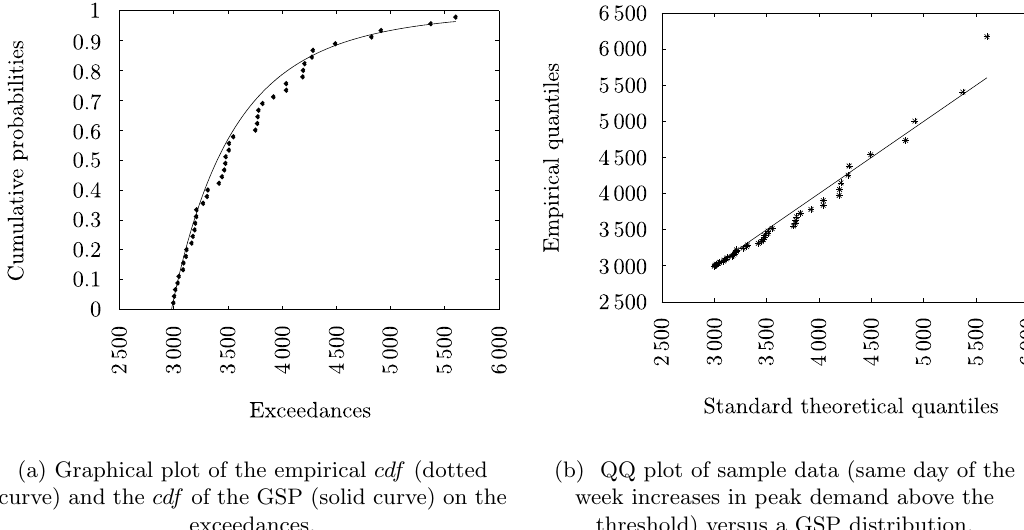
Figure 5: Using the GSP distribution to predict future observations.